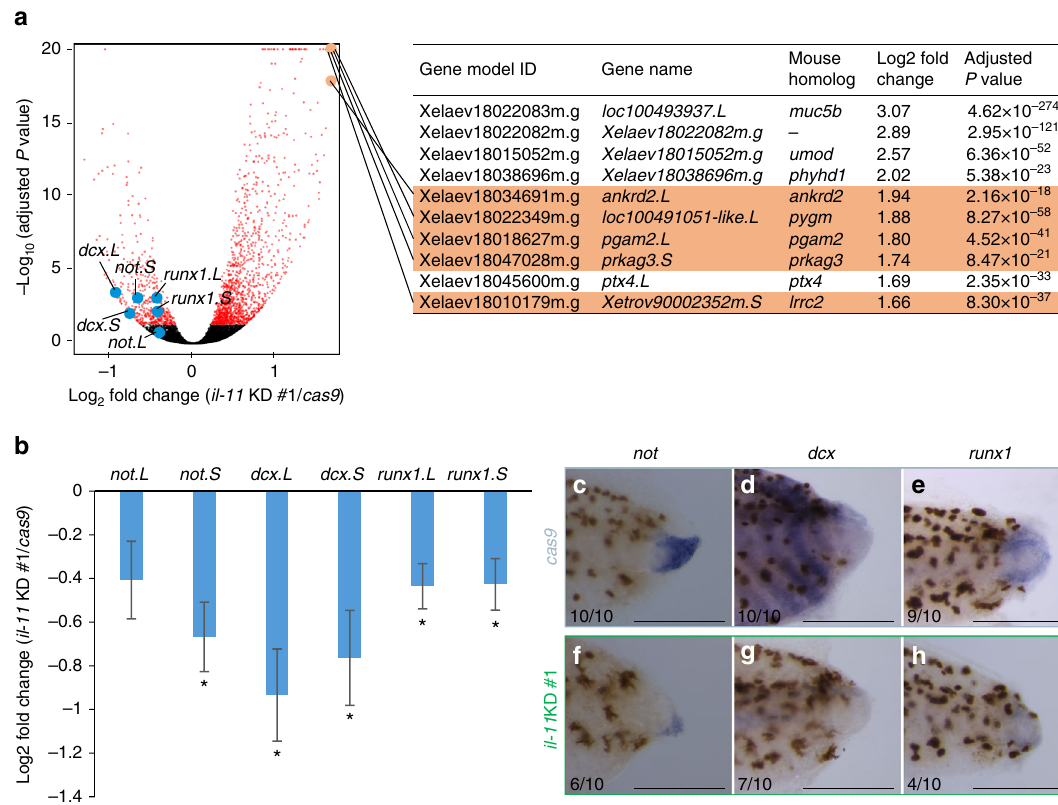
Fig. 5 il-11 induces or maintains tissue progenitor cells across cell lineages during tail regeneration. a Gene expression pro fi le of il-11 KD #1 and cas9 tadpoles. Left panel : volcano plot. Fold-change of expression level of il-11 KD #1 tadpoles over control tadpoles measured by RNA-sequencing are plotted on horizontal axis in log 2 scale, and adjusted P -values are plotted on vertical axis in – log 10 scale. Genes with signi fi cant fold-changes (adjusted P < 0.05) are plotted in red . Points beyond the range are plotted on the edge of the graph. Representative undifferentiated markers are plotted in blue . Right panel : top 10 genes which showed highest upregulation in il-11 KD #1 are listed. Mouse homologues of genes indicated in orange are reported to be selectively expressed in skeletal muscle in mice (Supplementary Fig. 7). These genes correspond to orange plots in the left panel . b Fold-change of expression levels of representative undifferentiated markers measured by RNA-sequencing. Mean ± s.e.m. n = 3. *adjusted P < 0.05, Wald test. c – h , Localisation of undifferentiated markers. Representative WISH images for not c , f , dcx d , g , or runx1 e , h in control c – e or il-11 KD #1 tadpoles f – h are shown. Anterior is to the left , dorsal is up . Blue / purple colour represents signals for the genes. Brown pigments are melanophores of the tadpoles. Scale bars : 500 μ m. Numbers at the bottom corner indicate the total ratio of tadpoles showing the corresponding expression pattern from two